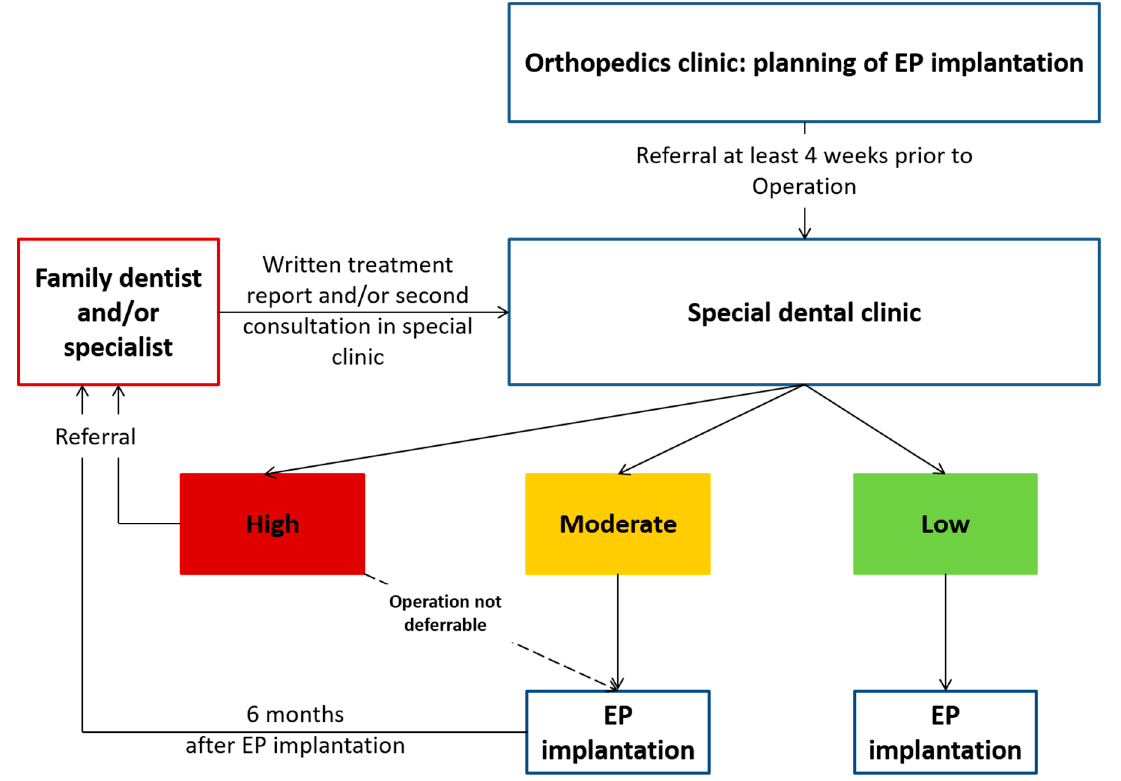
Figure 1. Concept of dental consultations and referral of patients before EP.